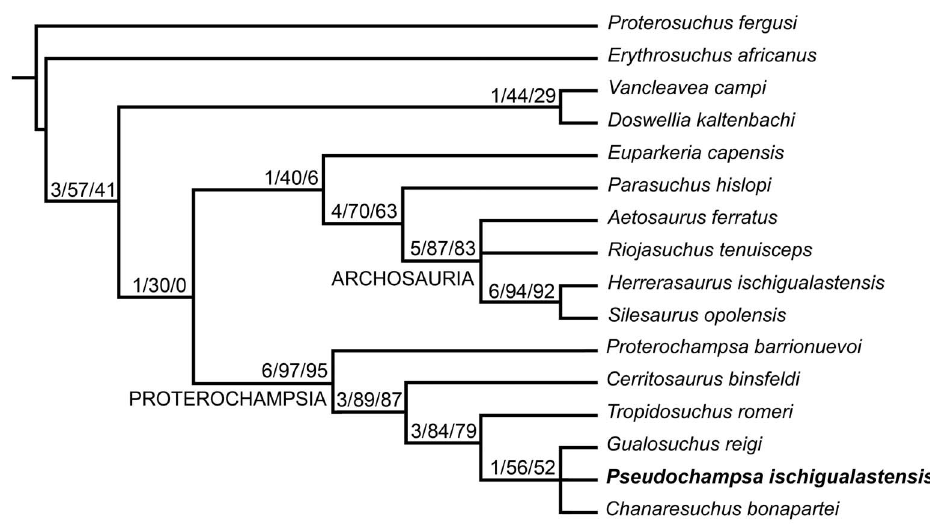
Figure 14. Phylogenetic relationships of Pseudochampsa ischigualastensis and other proterochampsians among basal archosauriforms. Numbers above nodes are Bremer support, absolute and GC bootstrap frequencies,